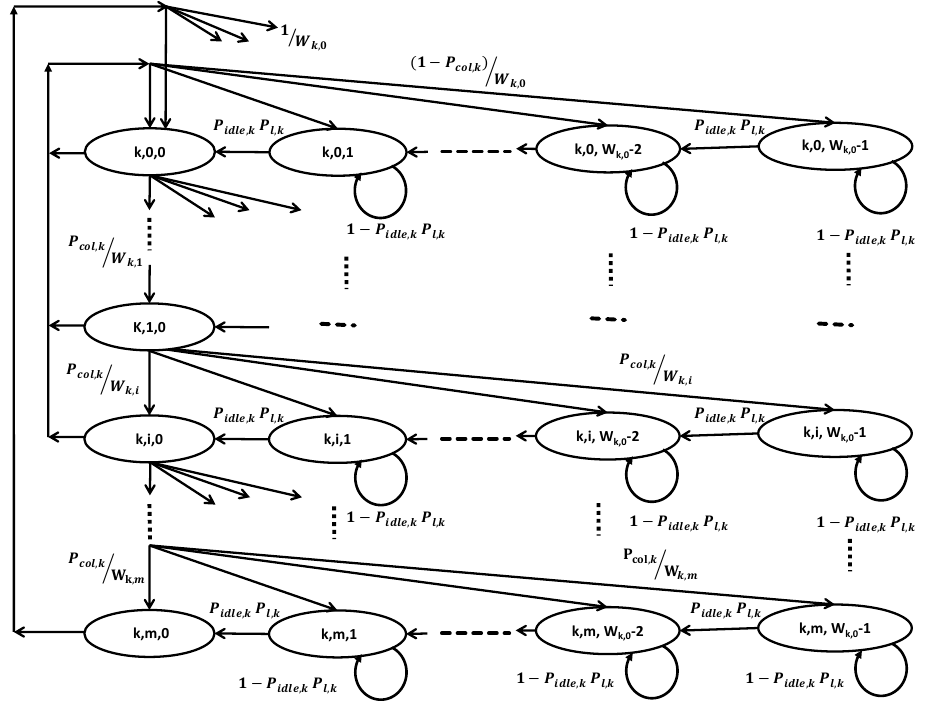
Figure 2. Markov chain model for IEEE 802.15.6 and Proposed